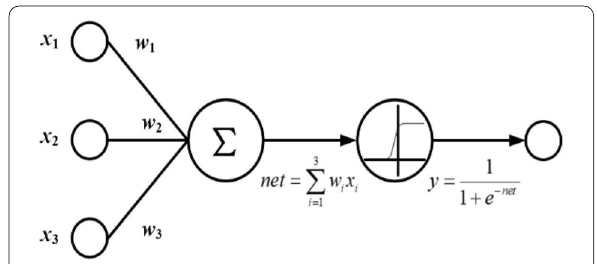
Figure 11 Sigmoid threshold unit